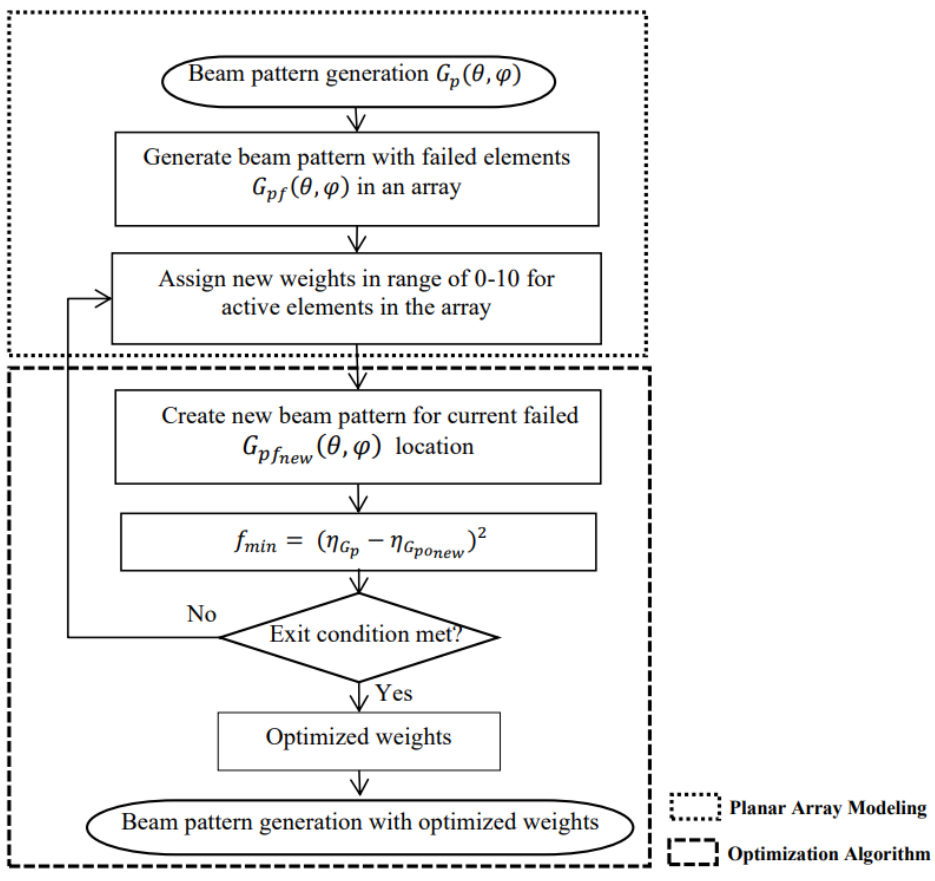
Figure 1. Flowchart of failed radiation pattern correction methodology.